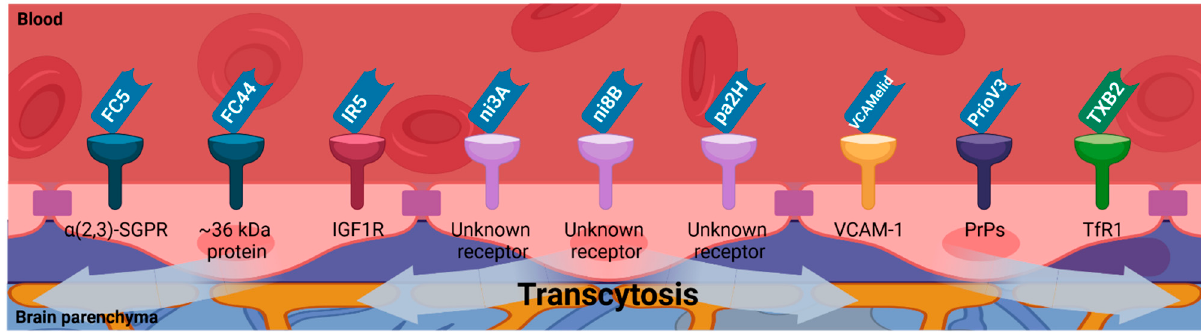
Figure 3. Single-domain antibodies (nanobodies and VNARs) BBB permeability due to receptor-mediated transcytosis. Several membrane receptors which are present on the surface of the endothelial cells of the BBB have been proposed to mediate the transcytosis of single-domain antibodies (nanobodies and VNARs) to transport them into the brain parenchyma (alpha(2,3)-sialoglycoprotein receptor ( α (2,3)-SGPR); insulin-like growth factor 1 receptor (IGF1R); vascular cell adhesion molecule 1 (VCAM-1); prion proteins (PrPs); transferrin receptor-1 (TfR1)). Image created with BioRender.com (accessed on 17 June 2021).